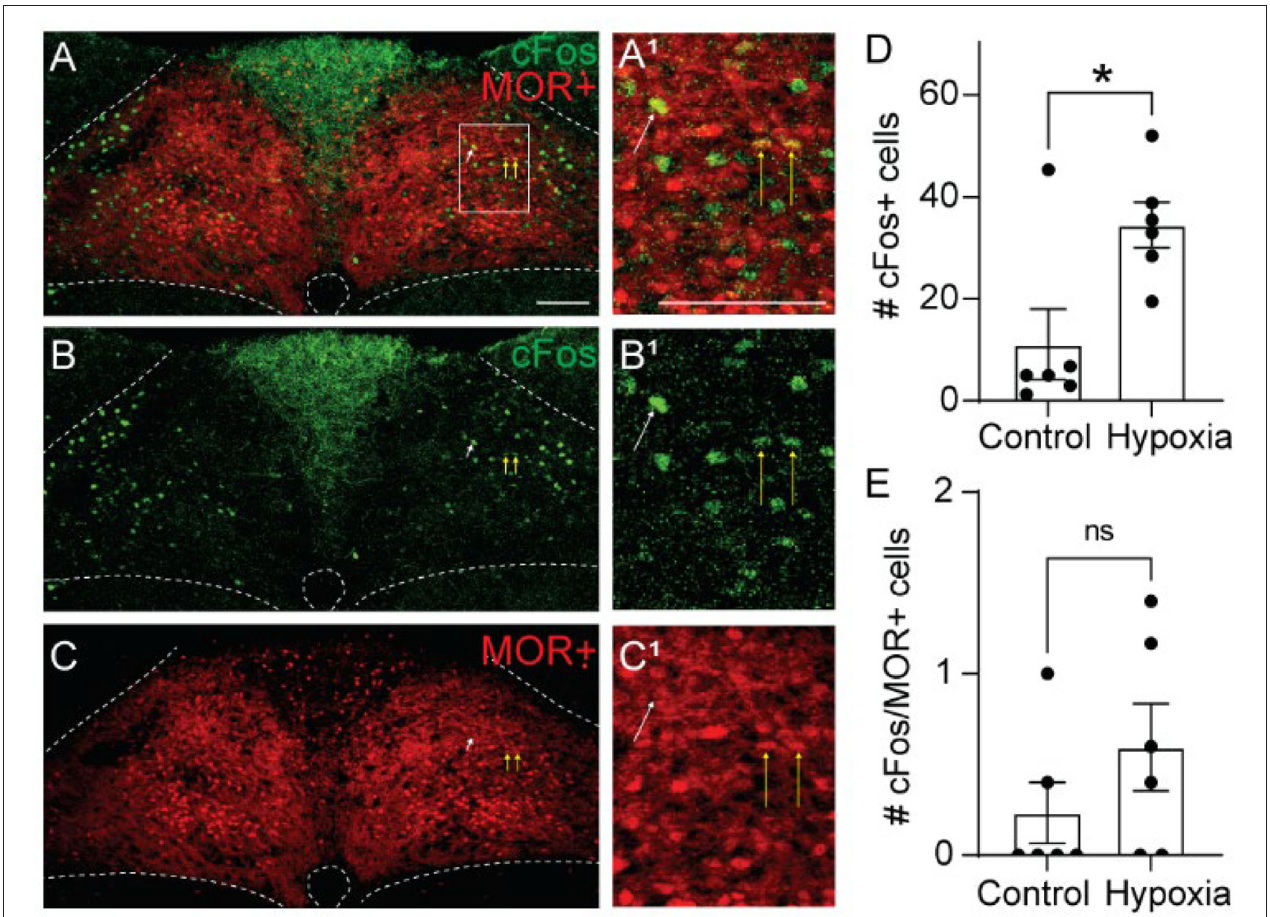
FIGURE 4 | Hypoxia activates MOR-negative neurons. Identification of cFos immunolabeling and tdTomato expression, as an indicator of MOR expression, in the NTS of Oprm1 Cre / tdT mice that were exposed to standard air (Control) or hypoxic air (10% O2). (A–C) Example images of cFos immunostaining (green) and MOR + tdTomato expression (red) from a mouse exposed to hypoxia. Very few cells co-expressed cFos and tdTomato (indicated by yellow vertical arrows). White diagonal arrows are pointing at example cells that are cFos + , but do not express MORs. (A 1 –C 1 ) are zoomed in views of the boxed region in (A–C) . Scale bar = 100 µ m. (D,E) Summary data of the average number of cFos + NTS cells per section (D) , or the average number of co-labeled cFos + /MOR + NTS cells per section (E) ( n = 6 mice/group, 4–6 sections/mouse). Each data point represents the average # of cFos + cells per section for an individual mouse. Bar and error are group mean ± SEM. * p < 0.05; ns, p > 0.05 by unpaired t-